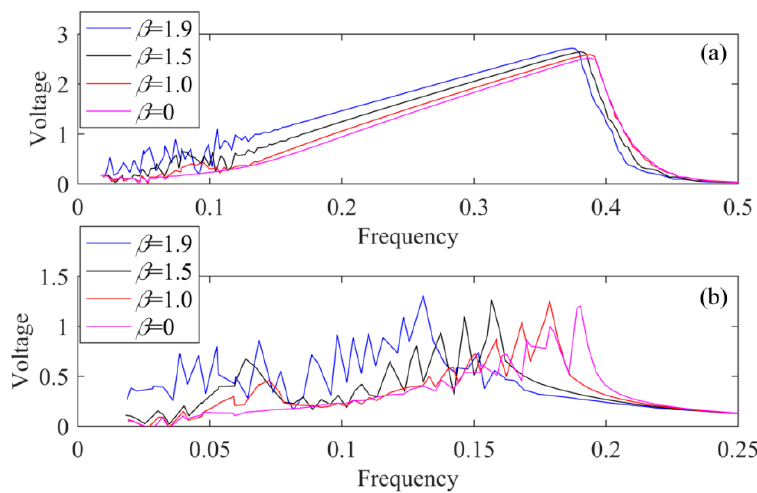
10 of 15 Figure 8. PDF Probability density function of dimensionless displacement for different values of quadratic coefficient. 4. Response of the Asymmetric MEHs under Band-limited Noise In this section, we focus on considering the response characteristics of asymmetric potential MEHs subjected to band-limited noise excitation. Before discussing the response under band-limited noise excitation, the response under harmonic excitation is empha- sized. Under an up-sweep frequency excitation with a level of 0.2, the voltage responses of four MEHs with different values of the quadratic coefficient are shown in Figure 9a. The MEHs could generate a larger voltage in a wider frequency range. With the increase in asymmetric degree, the response bandwidth was slightly enlarged around the cut-off frequency (COF-1) while the response amplitude was slightly decreased. For a down- sweep frequency excitation, the response voltage of the four MEHs was depicted in Figure